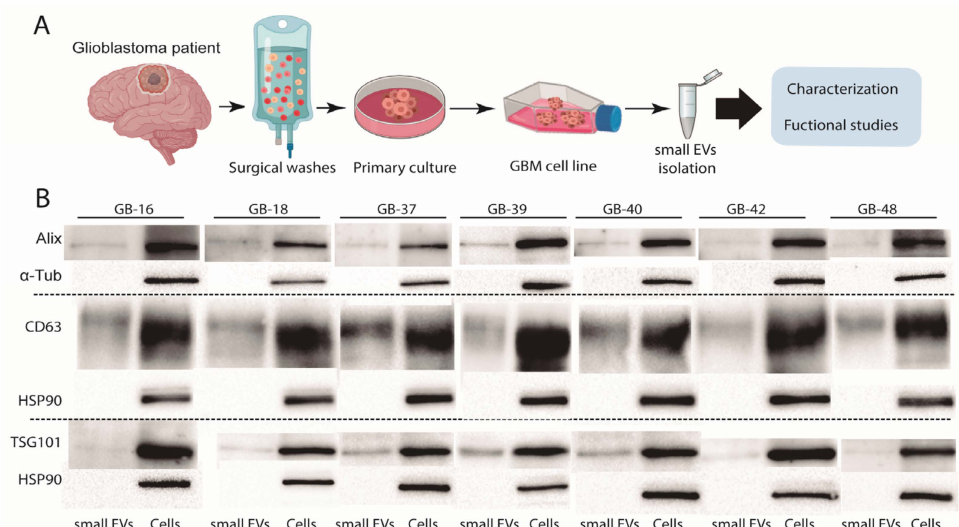
Figure 1. Small EVs isolation and biochemical characterization. ( A ) Scheme of the GBM cell line obtention, followed by small EVs isolation and functional studies. ( B ) Expression by WB of Alix, CD63, and TSG 101 in isolated small EVs and corresponding cell protein extracts. α -Tub and HSP-90 were used as control. Of note, HSP-90 in GBM is not a biomarker and has been used as a marker of small EVs isolation (negative control). GBM, glioblastoma; EVs, extracellular vesicles.